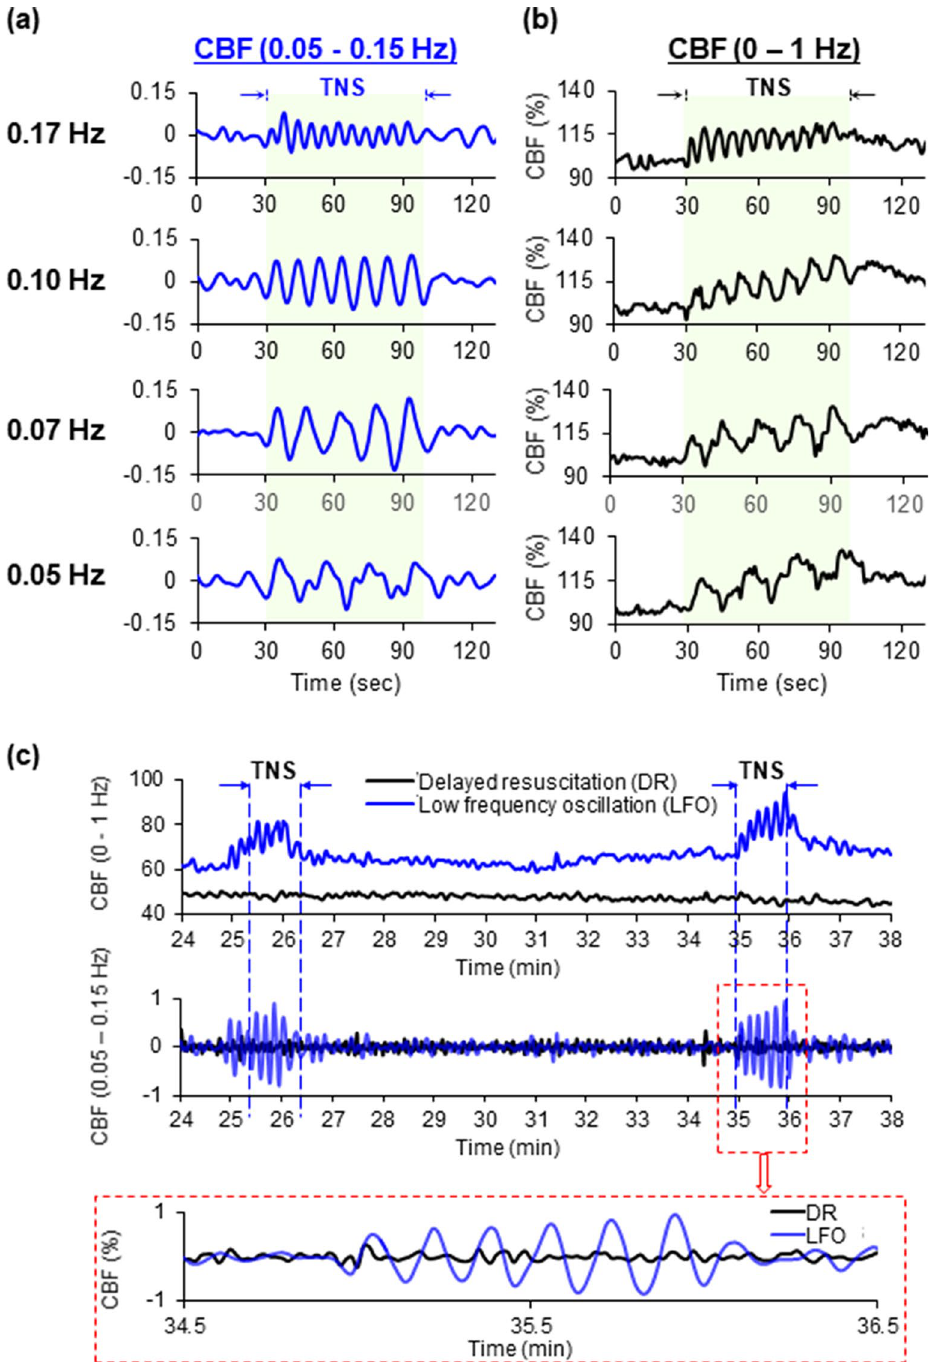
Figure 1. ( a ) TNS induces controllable and repeatable CBF oscillations in the target low-frequency range of 0.05–0.15 Hz. ( b ) During the stimulation, TNS gradually improves the overall peak and average amplitudes of CBF. ( c ) After TBI + HS, TNS can induce the targeted low-frequency CBF oscillations. The representative recordings of TNS-induced CBF oscillations at 0.1 Hz after TBI + HS are shown. All of the data are presented as mean ± SD. * p < 0.05 versus DR, # p < 0.05 versus IR, n = 10 for each group. CBF: cerebral blood flow; CCI: controlled cortical impact; DR: the animals received 60 min delayed fluid resuscitation; IR: the animals received immediate fluid resuscitation; LFO: the animals received low-frequency CBF oscillations immediately after TBI + HS onset and followed by fluid resuscitation; TNS: trigeminal nerve